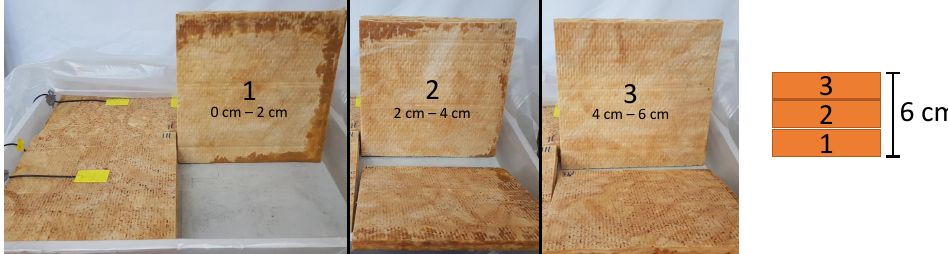
Figure 11. Water ingress (dark dyeing) in the 6 cm GW insulation. The pictures show the respective bottom of each used insulation plate (40 cm × 40 cm × 2 cm) in quadrant IV.